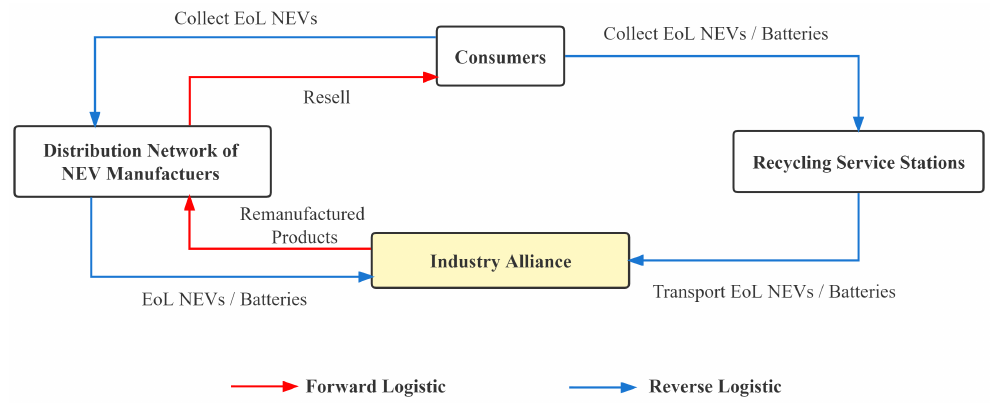
Figure 6. Industry alliance recycling